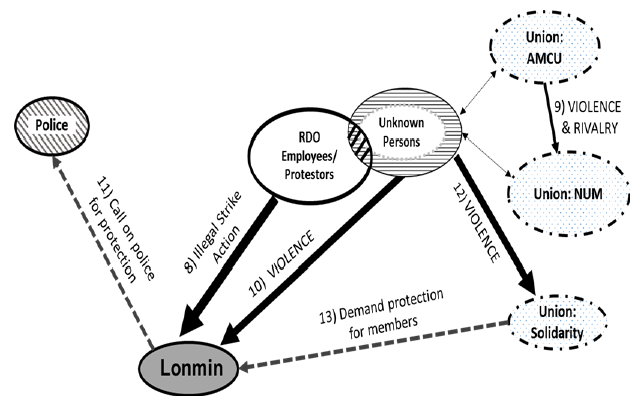
Figure 4: Stakeholder model for Lonmin (Period 11 to 15 August: Part 1)